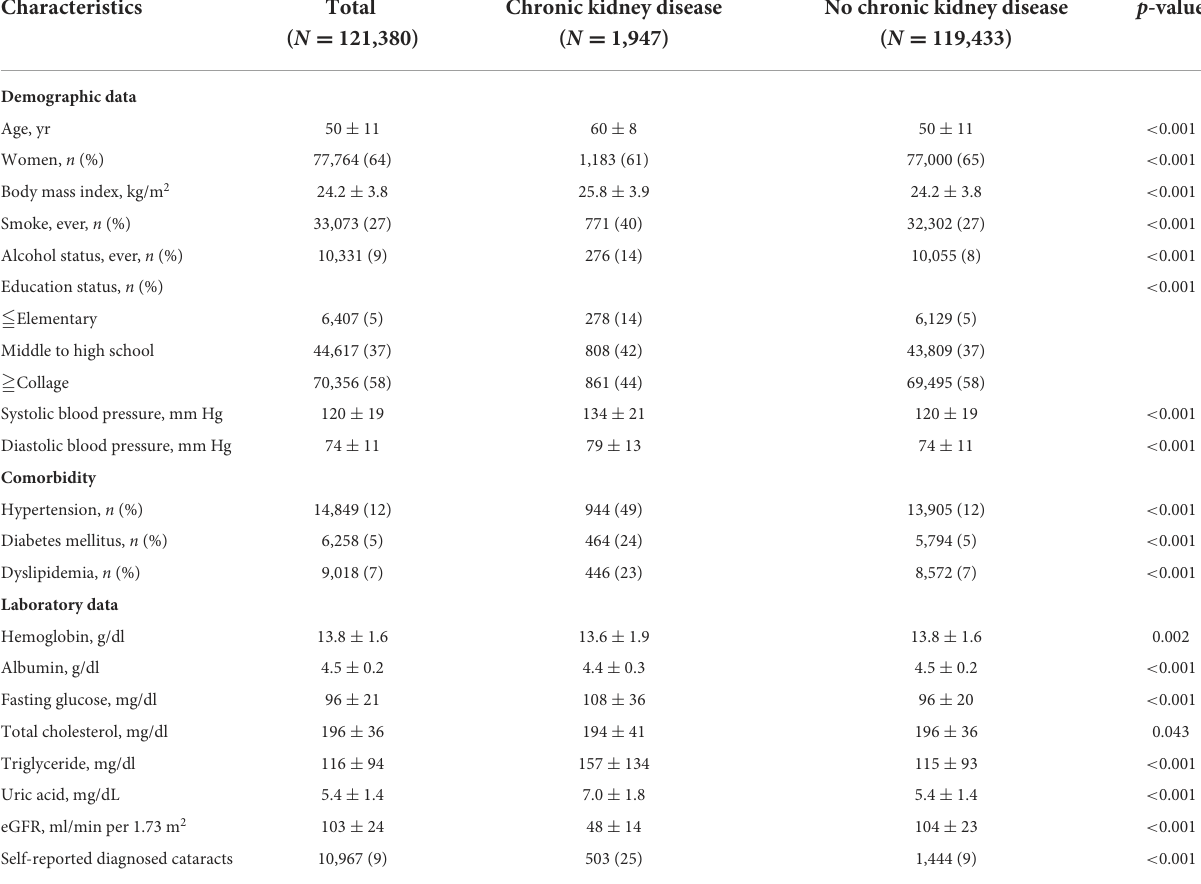
TABLE 1 Clinical characteristics of the cross-sectional cohort ( n =